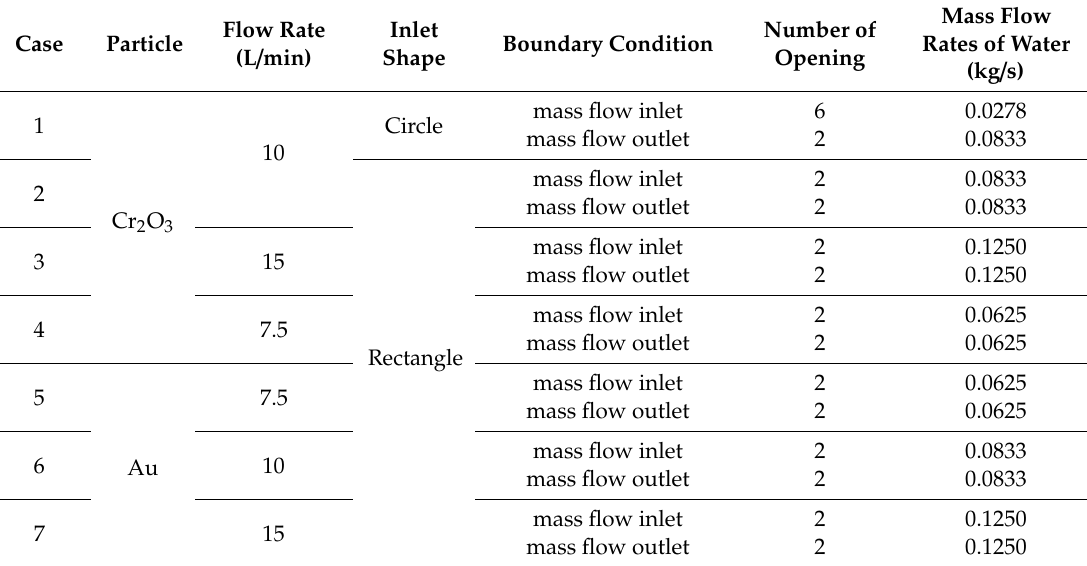
Table 2. Cases and boundary